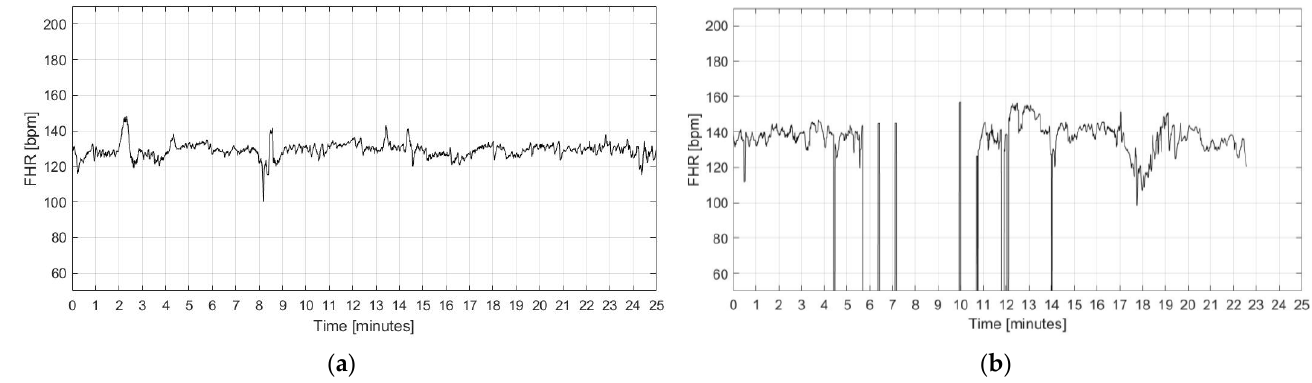
Figure 2. Examples of FHR signals: ( a ) included in the analysis; ( b ) excluded from the analysis due to the presence of artifacts and signal loss.